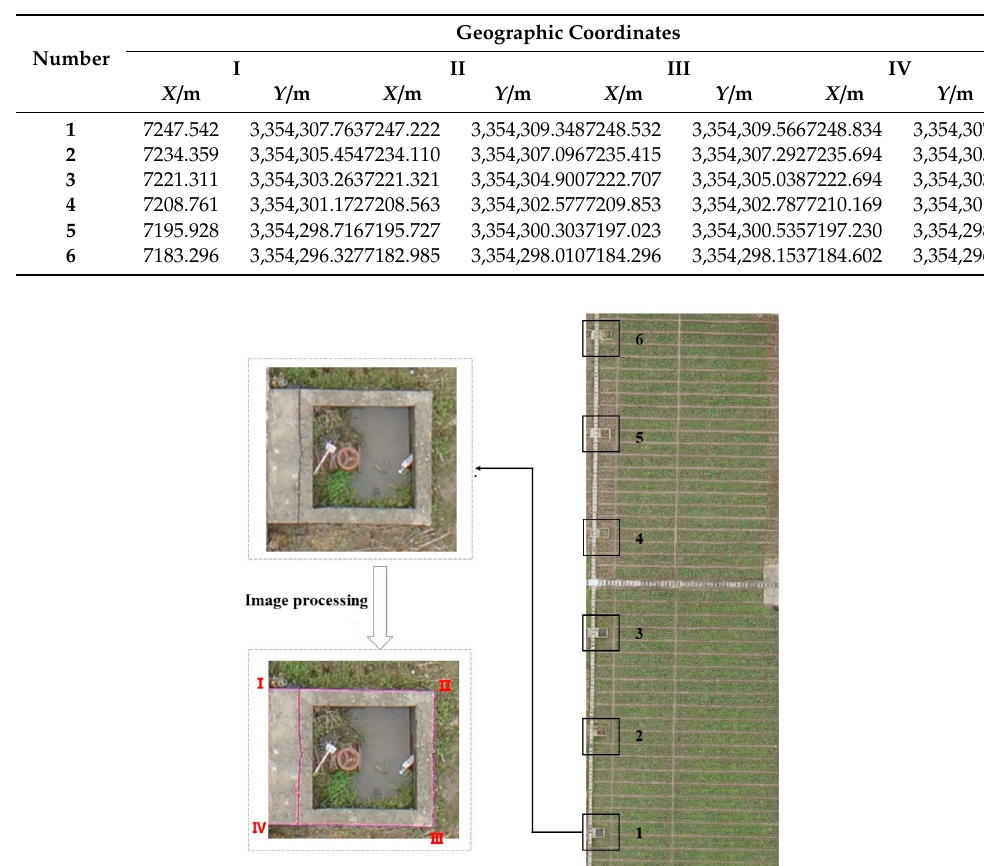
Table 4. Corner coordinates of obstacles extracted by ArcGIS.